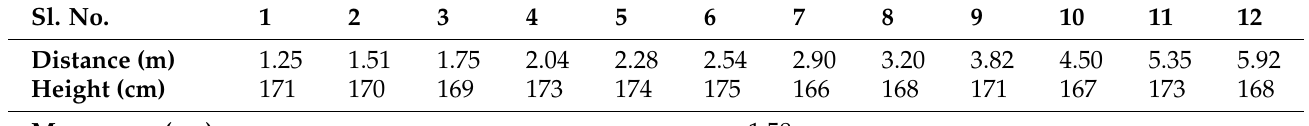
Table 1. User height estimate accuracy from lidar data at different distances.